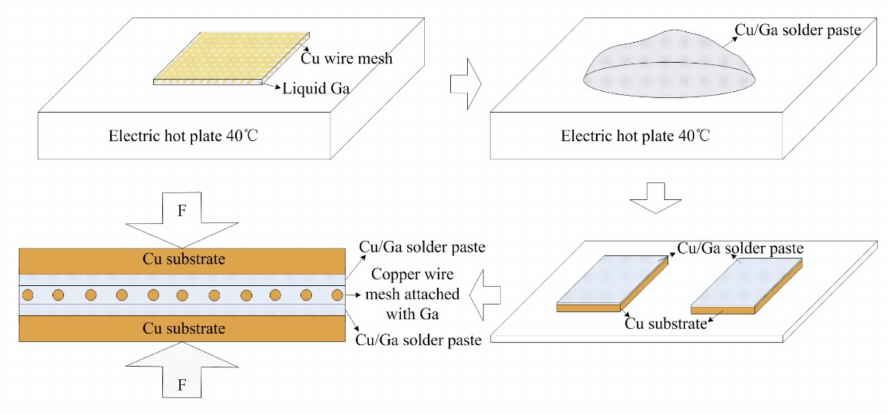
Figure 1. The schematic diagram of the bonding